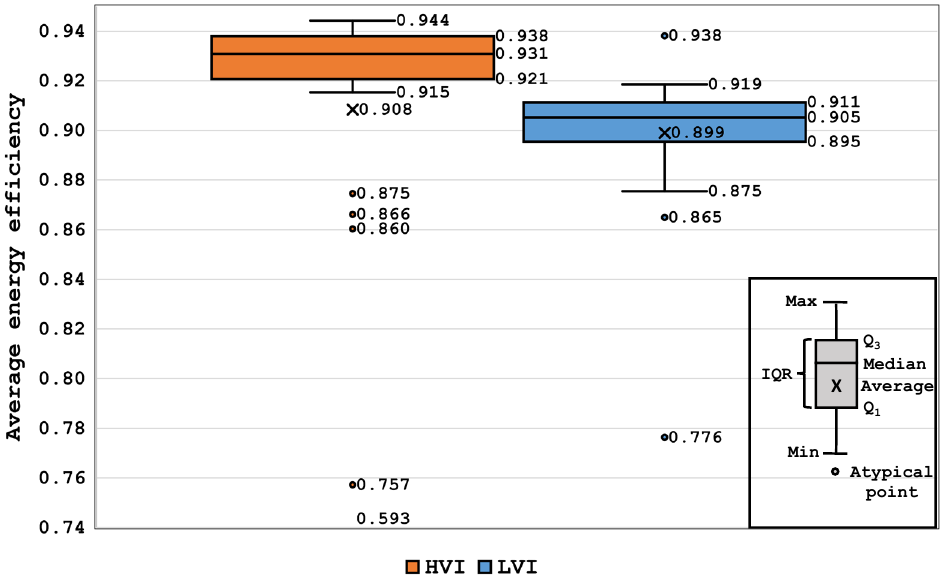
Figure 11. Distribution of η i . 𝜂𝜂 𝚤𝚤 �